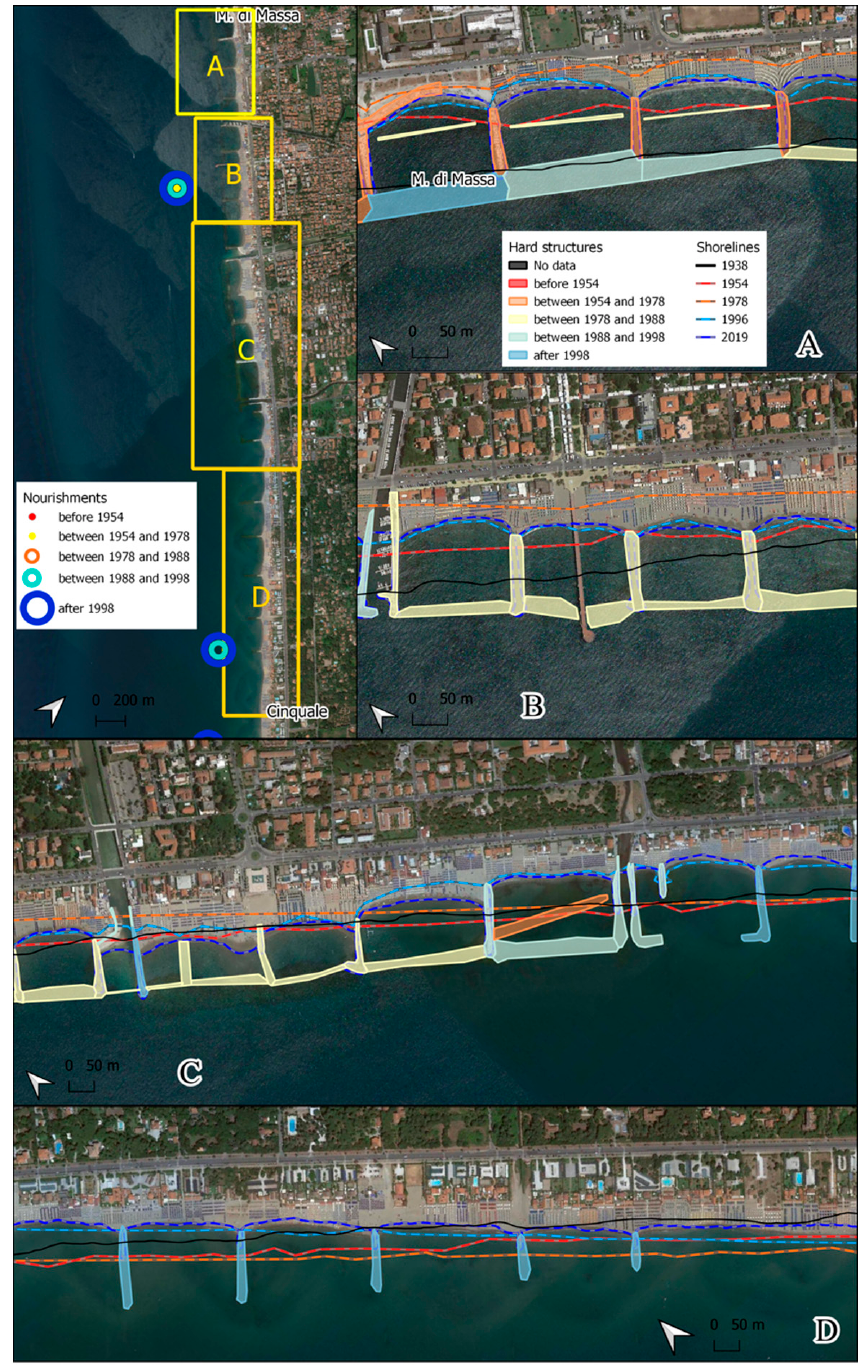
Figure 4. Identification of hard and soft operations along the sector comprised between Marina di Massa and Cinquale. Polygons represent the hard structures; dots represent the nourishments. The yellow frames in the top left panel correspond to the zoom in panels to the right and at the bottom. The background image has been retrieved from the Google Earth database.